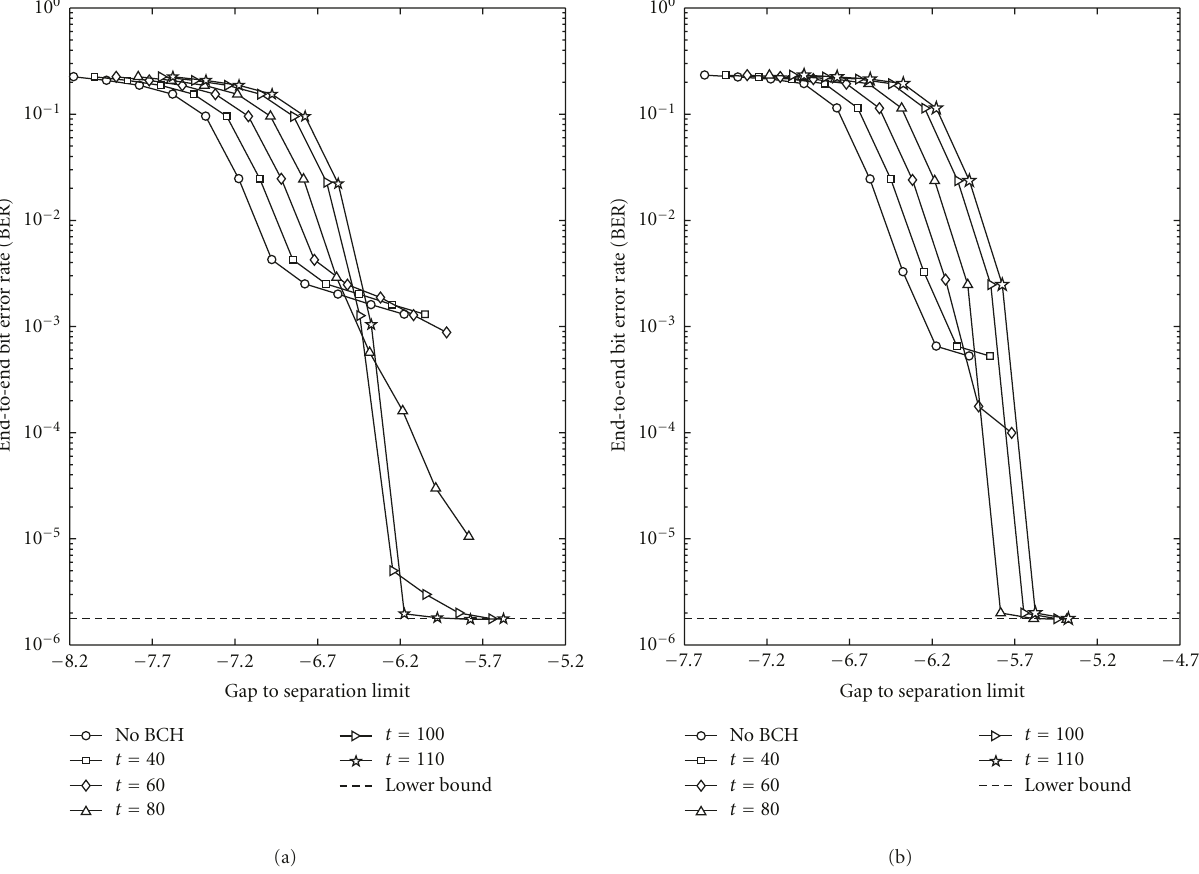
Figure 7: End-to-End BER versus gap to separation limit E b /N 0 − E ∗ b /N 0 for N = 6 sensors, di ff erent BCH codes and (a) [ d c d v ] = [10 5]; (b) [ d c d v ] = [12